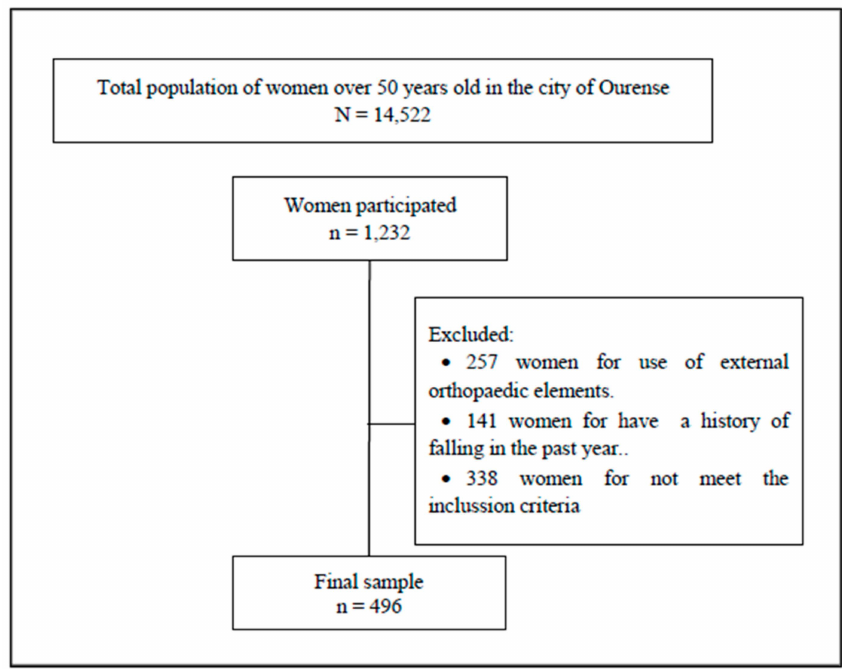
Figure 1. Consort flow